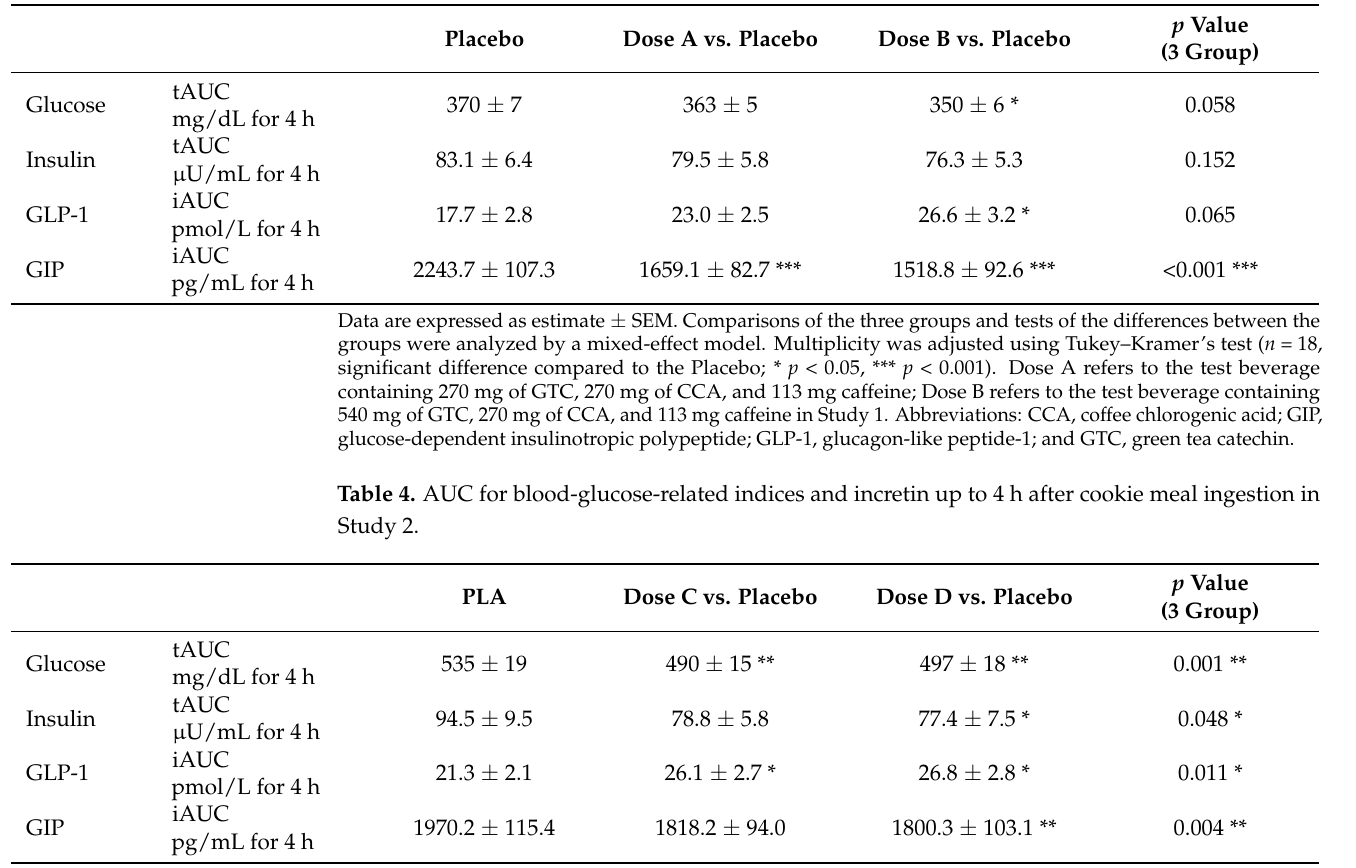
p Value (3 Group)